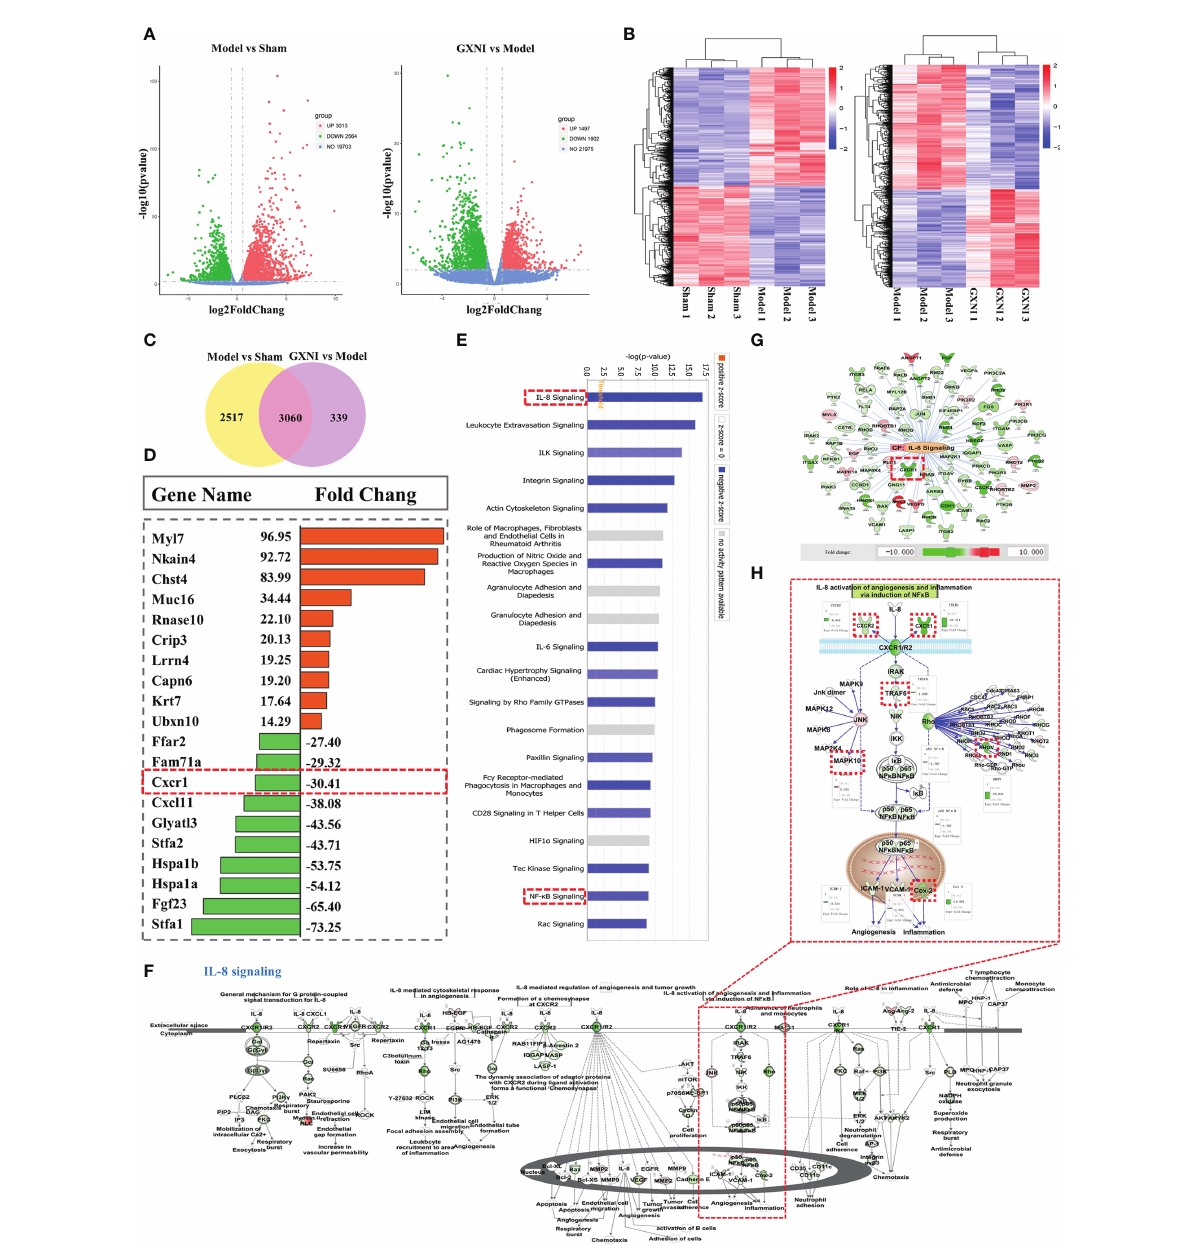
FIGURE 3 Transcriptome sequencing results and IPA analysis. (A) The differential gene distribution (fold change ≥ 1.5 and p value ≤ 0.01) among the sham group, I/R (Model) group and GXNI 9 mL/kg group was displayed through a volcano graph. The abscissa and ordinate represented the fold change and the signi fi cance level of the difference in expression of the gene, respectively. Red dots were the up-regulated genes, and green dots were the down-regulated genes. (B) Hierarchical cluster analysis among samples of sham group, I/R group and GXNI (9 mL/kg) group. Each group included three independent animals (n = 3). (C) Venn diagram of MIRI group vs. Sham group and GXNI group vs. MIRI group. (D) List of the top 10 genes with up-regulated fold change and the top 10 genes with down-regulated fold change among the 3060 DEGs shared by I/R model vs. sham and GXNI vs. I/R model. (E) Core analysis revealed the top 20 pathways of 3060 DEGs which were arranged in descending order according to -log (p-value), with IL-8 signal pathway being number one. (F) The schematic diagram of the interaction of genes in the IL-8 signaling pathway. (G) Gene targets that are regulated by GXNI in IL-8 signaling pathway. (H) A schematic diagram of gene interactions in CXCR1-NF- k B-COX-2/ICAM-1/VCAM-1 pathway. In A – H , GXNI-regulated genes in the transcriptome data are color labeled, with green representing down-regulation and brown representing